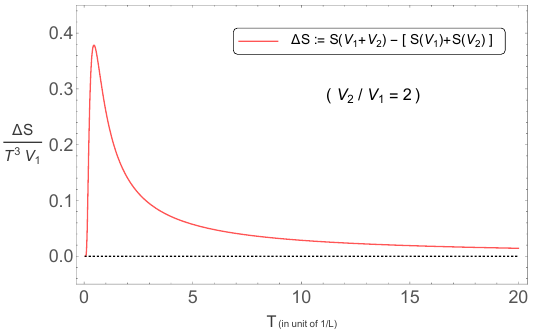
Figure 5. Non additivity of the entropy as a function of the temperature, due to the spatial compactification. The quantity is plotted as a function of T in unit of 1/ L , but goes to zero in the limit L → ∞ , and is normalized to appropriate powers of the temperature and volume. One subsystem ( V 2 ) is twice as large as the